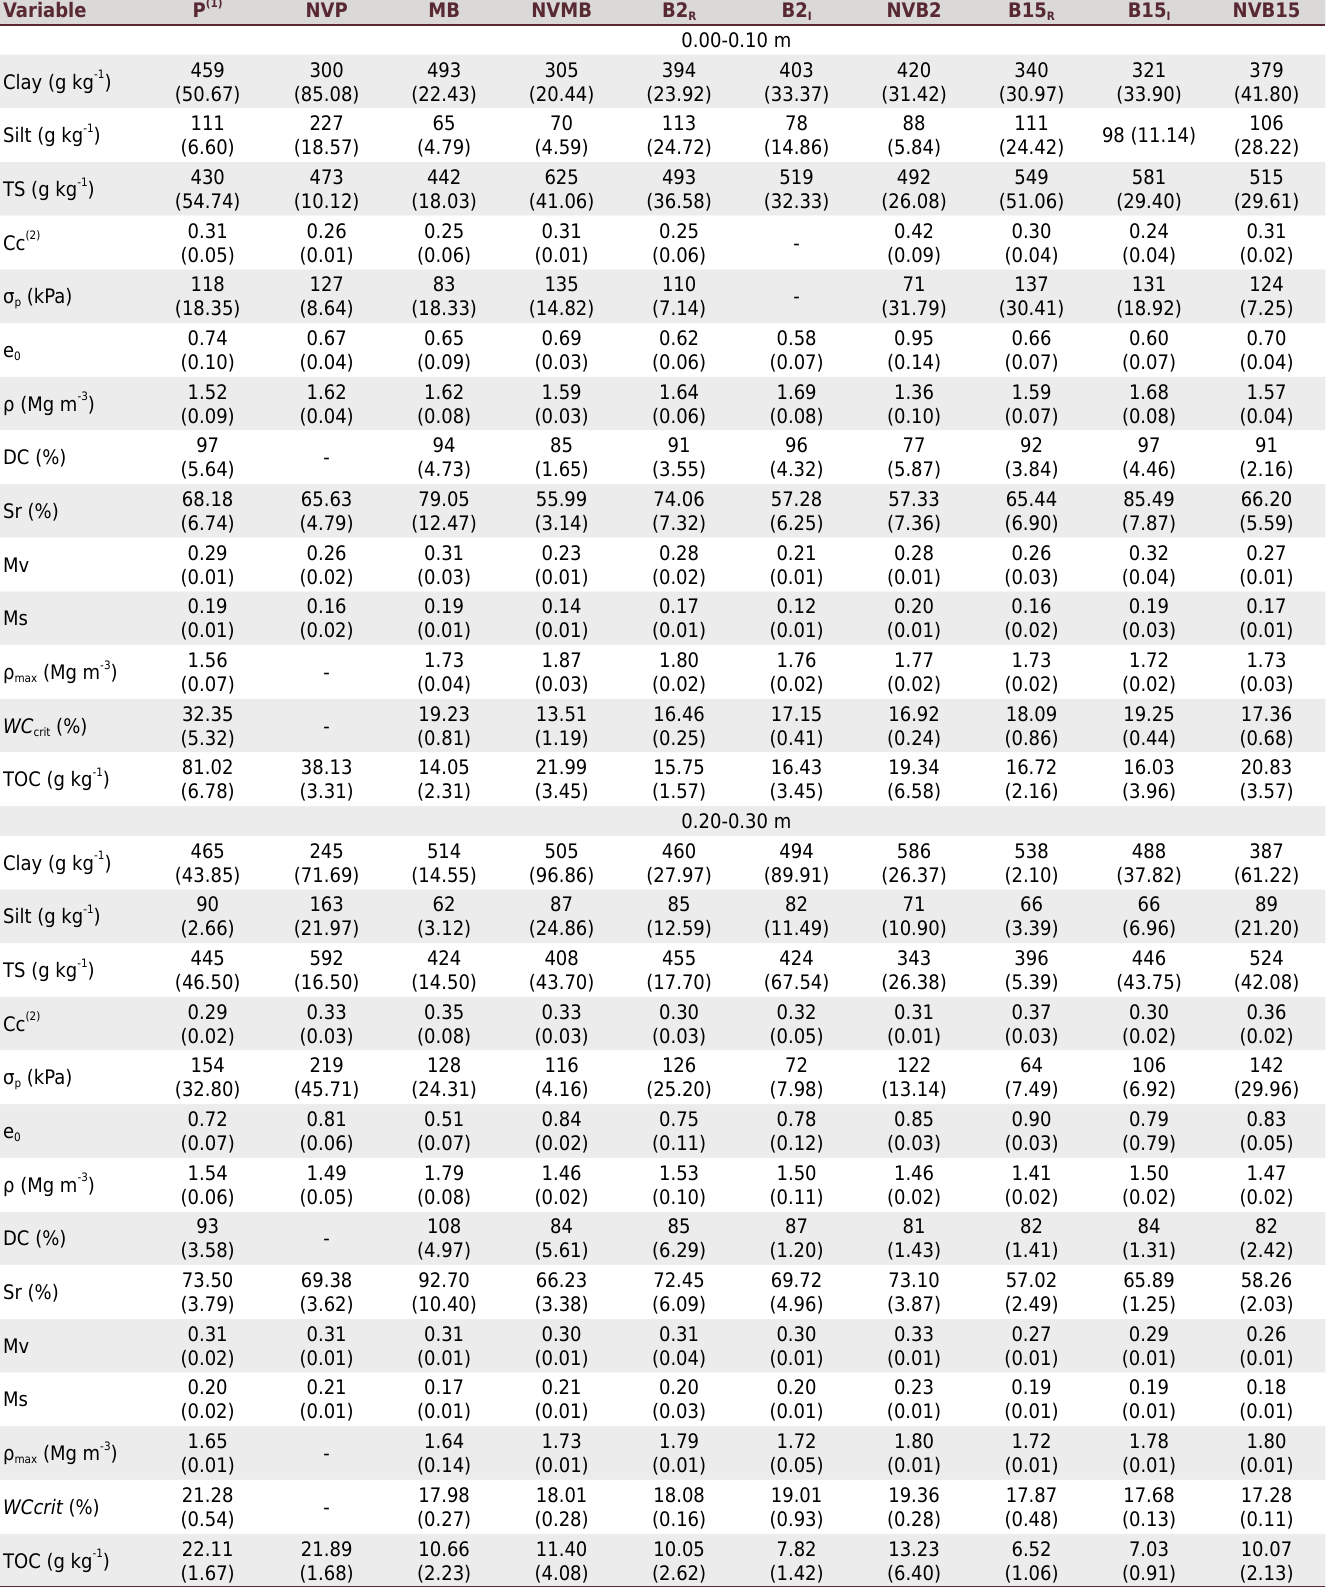
Table 2. Means and standard deviation of the physical and chemical properties of the soil at layers of 0.00-0.10 and 0.20-0.30 m in areas under irrigated cultivation and natural vegetation (NV) in the Jaguaribe Irrigated Area, Apodi, CE, Brazil, n=4